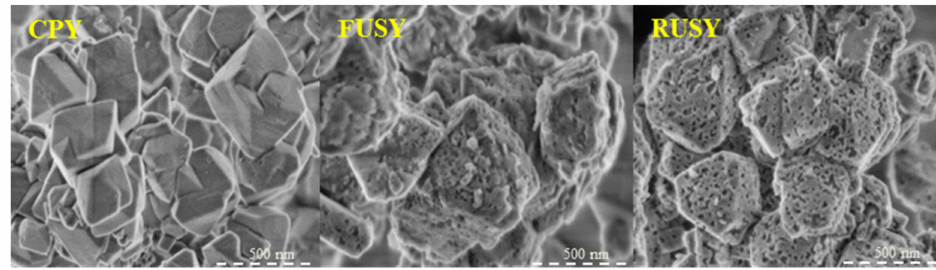
Figure 2. SEM images of three Y-zeolite